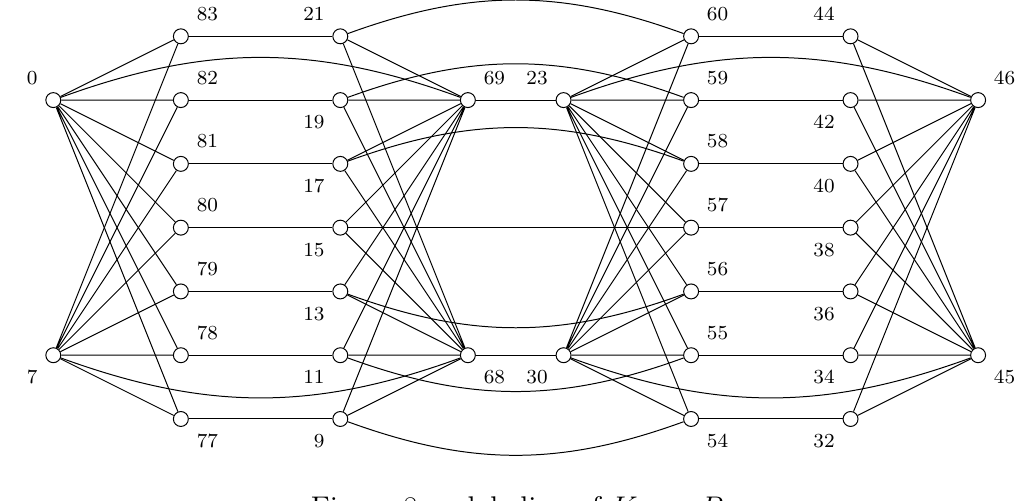
Figure 8: α -labeling of K